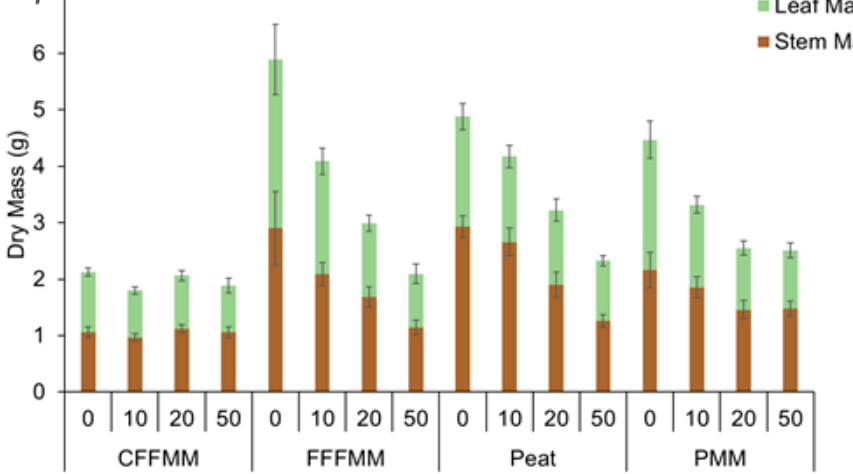
Figure 3. Dry leaf (green) and stem (brown) mass (g) for each soil type and 0%, 10%, 20% and 50% wood amount. Values are averages with standard error. cFFMM, coarse forest floor-mineral mix; fFFMM, fine forest floor-mineral mix; PMM, peat-mineral mix.